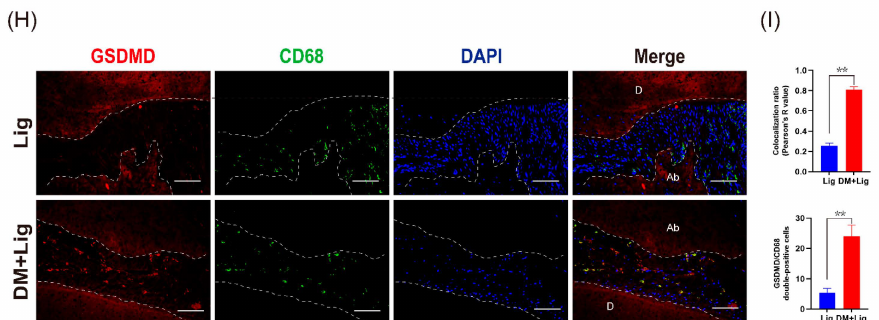
Figure 1. Diabetes mellitus–periodontitis presented exacerbated bone resorption and aberrant activa- tion of macrophage pyroptosis. ( A ) Representative 3D reconstructions and transverse section images of control (CON), diabetes mellitus (DM), ligature-induced periodontitis (Lig), and DM + Lig groups. The green area displays the exposure of the root (scale bar: 1 mm). ( B ) Bone volume/total volume (BV/TV). ( C ) Representative images of HE staining (upper panel) in coronal sections of periodontal tissue (scale bar: 1 mm). Representative images of TRAP staining (lower panel) in the furcation region of the second molar (scale bar: 200 µ m). ( D ) Distances between the CEJ and the ABC. ( E ) Quantitative analysis of osteoclast number at the alveolar bone. ( F ) Immunohistochemistry staining against IL-1 β and GSDMD of periodontal tissues (scale bar: 200 µ m). Red arrows demonstrate GSDMD positive cells. ( G ) Quantitative analysis of IL-1 β and GSDMD (total GSDMD and cleaved GSDMD) in the gingiva and the furcation of the second molar. ( H ) Representative images of immunofluorescence staining of macrophage marker (CD68) and pyroptosis marker (GSDMD) in the periodontium of the Lig group and the DM + Lig group. Nuclei were stained with DAPI (blue). Scale bar, 100 µ